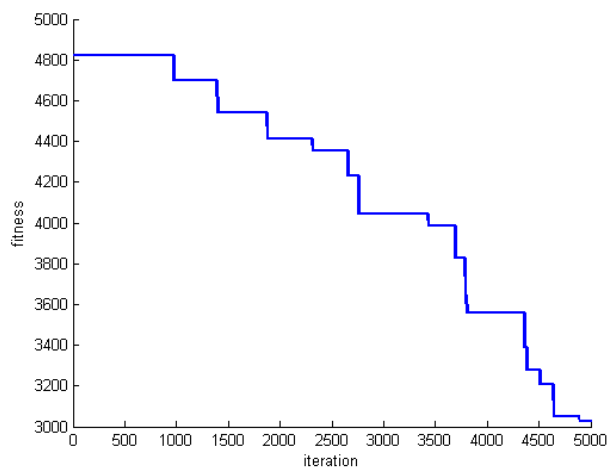
Figure 13. Changes of the best whale for a = 2 in DS 5